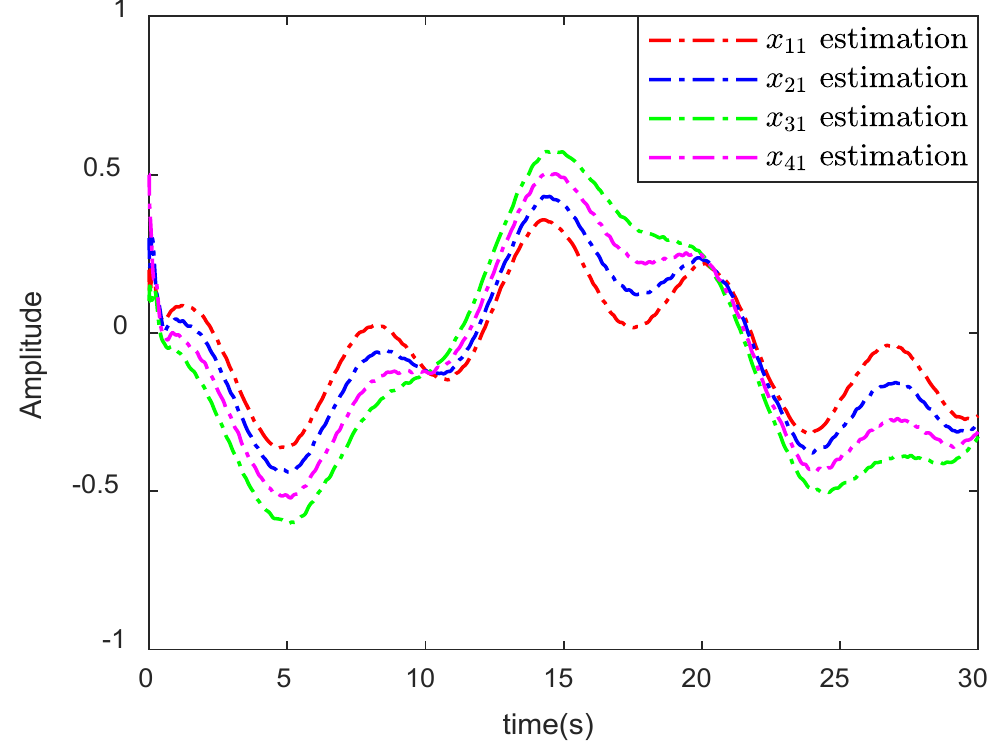
Figure 4. The trajectories of the x i ,1 ( i = 1, · · · ,4 ) estimation